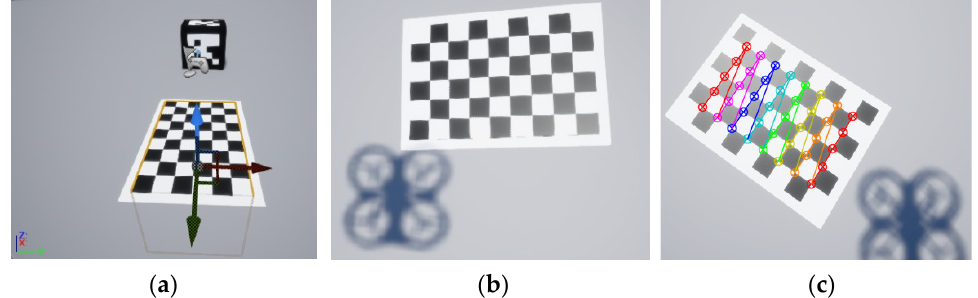
Figure 7. Simulation environment in the calibration process: ( a ) Image of the calibration pattern in the AirSim reference frame; ( b ) Random image of the image registration process; ( c ) Example of reprojection error.